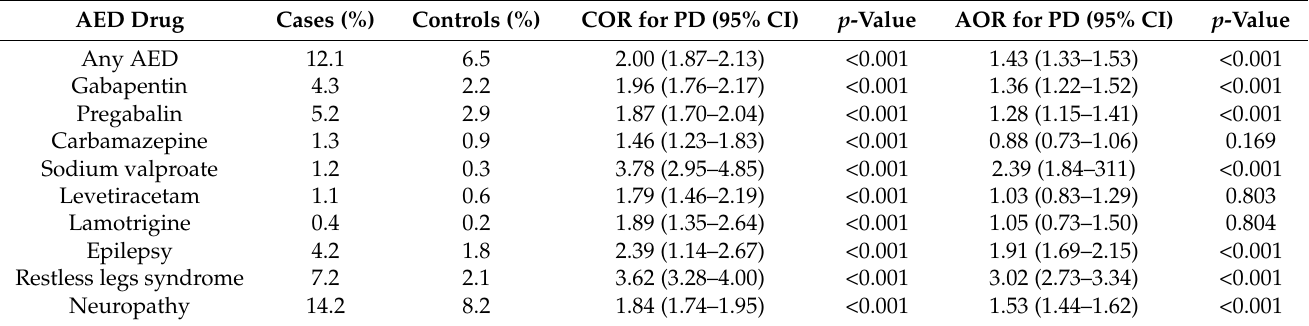
Table 2. Association between antiepileptic drugs and incident Parkinson’s disease among patients followed in German primary care